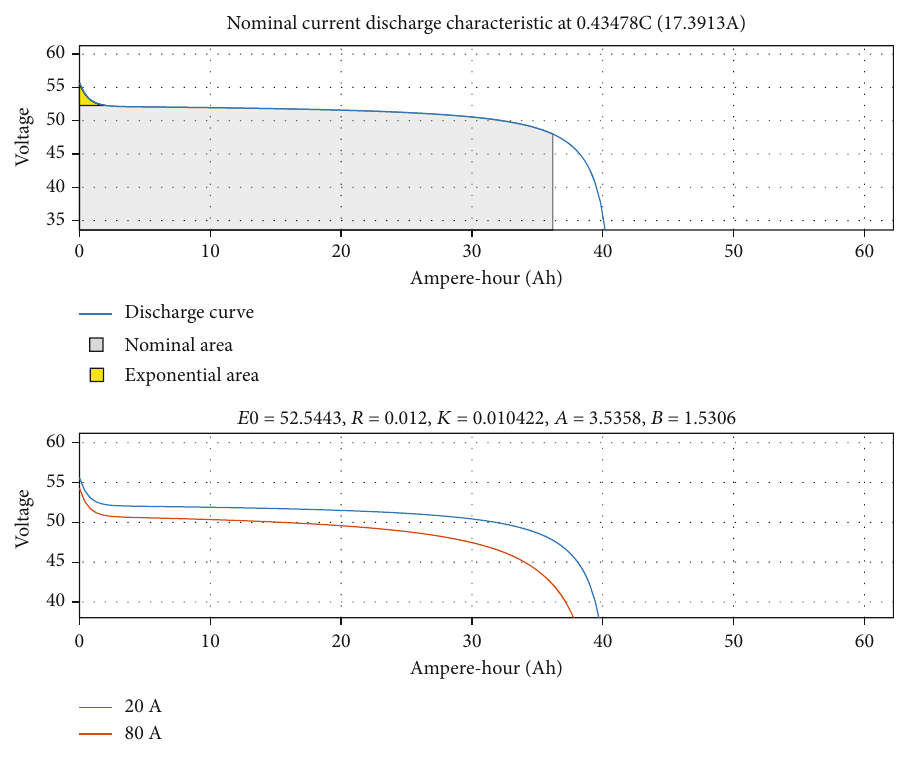
Figure 5: The dynamic behaviour of battery. Table 3: Supercapacitor model